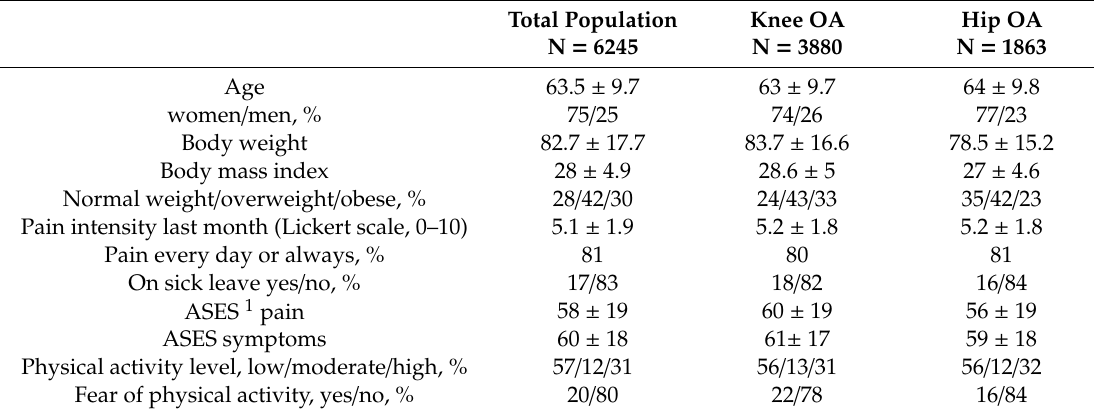
Table 2. Demographic data at inclusion for the total population and divided by the most a ff ected joint.